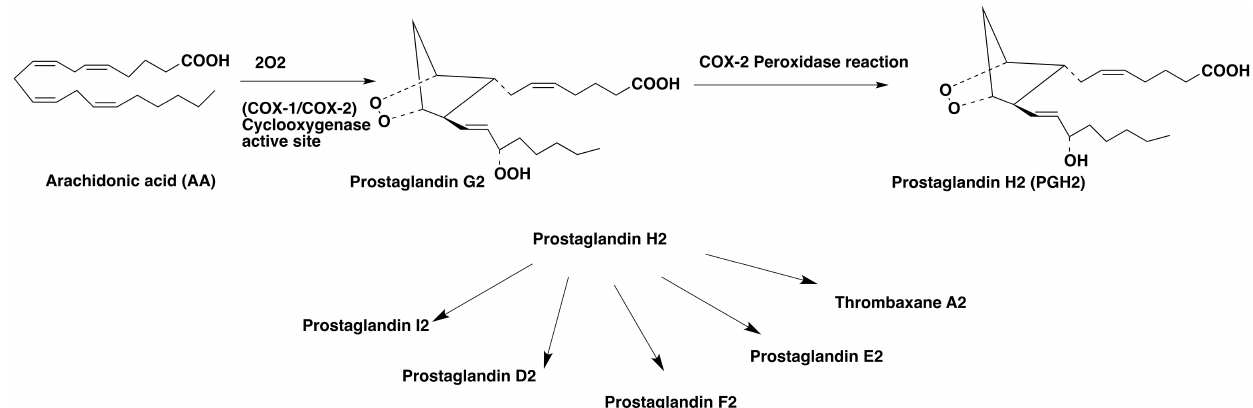
Figure 1. COX-2 mediated conversion of arachidonic acid into prostaglandin H2 (PGH2) and subsequent conversion of PGH2 into different